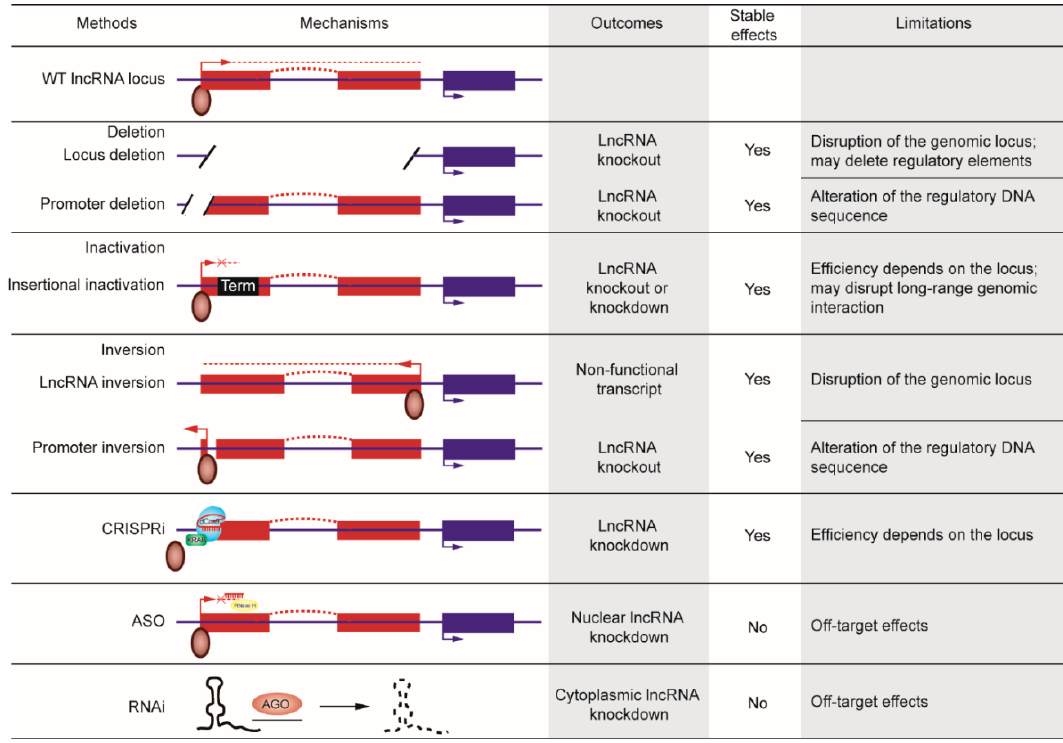
Figure 3. Loss-of-function approaches for investigating lncRNAs. Dark red rectangles: lncRNA exons. Dark blue rectangles: neighboring protein-coding genes. Brown ovals: transcriptional factors. Arrows: the direction of transcription. Black rectangle: transcriptional terminator (Term). Antisense oligonucleotides (ASOs) are illustrated by a complementary sequence to the nascent RNA transcript, which decreases lncRNA expression by triggering RNase H (yellow oval)-mediated cleavage. CRISPRi employs sgRNA-mediated targeting of dCas9 (light blue oval) to the region near the transcriptional start site to repress gene expression, and the repression is enhanced by fusing Cas9 with a repressor, such as the Kruppel-associated box (KRAB) domain (green rectangle). RNAi is triggered by short RNA species that bind to argonaute protein (Ago), which forms a complex to recognize complementary mRNA and lncRNA molecules and induce their degradation.